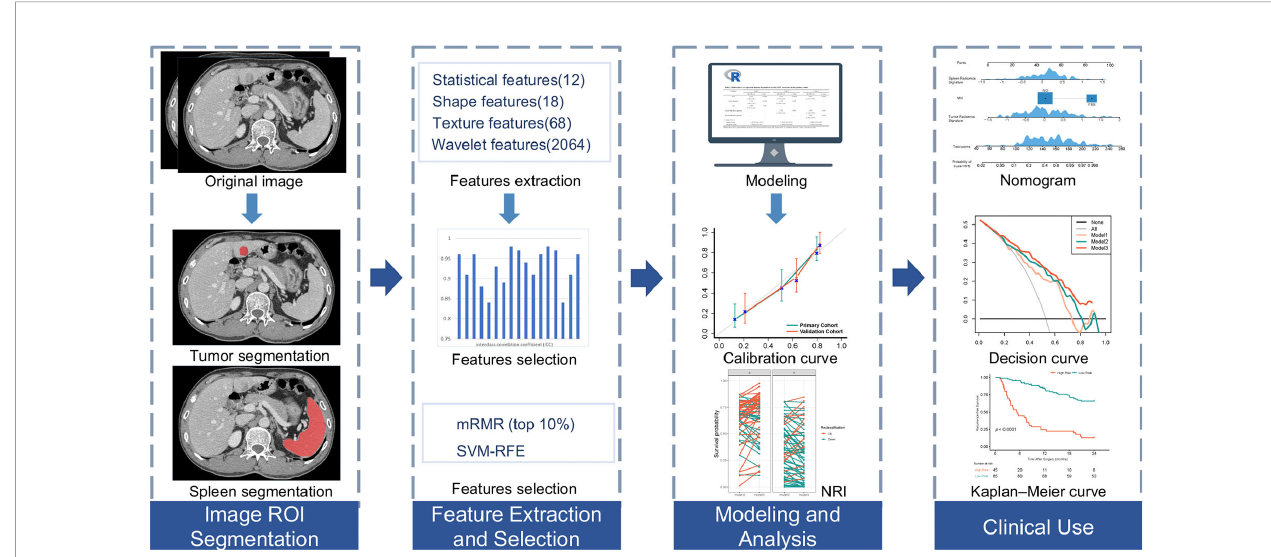
FIGURE 2 | Work fl ow of necessary steps in current study. The regions of interest (ROIs) of tumors are segmented manually on arterial phase and portal venous phase CT section, ROI of spleens are segmented on portal venous phase. Total of 2162 radiomic features were extracted from each ROI. For features selection, features with interclass correlation coef fi cient >0.85 were regarded as good agreement in reproducibility and used for subsequent analysis, and the maximum relevance – minimum redundancy (mRMR) and support vector machine-recursive feature elimination (SVM-RFE) method was used to select the most critical features, the least absolute shrinkage and selection operator method was performed to construct radiomics signature. The performance of the prediction model was evaluated by the concordance index, net reclassi fi cation improvement (NRI) and calibration curve. To provide an easy-to-use assessment tool, a nomogram was built, followed by decision curve analysis and survival